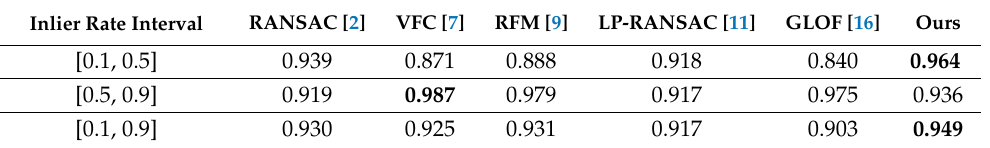
Table 1. Average F1-score comparison for the “Airport” dataset. Inlier Rate